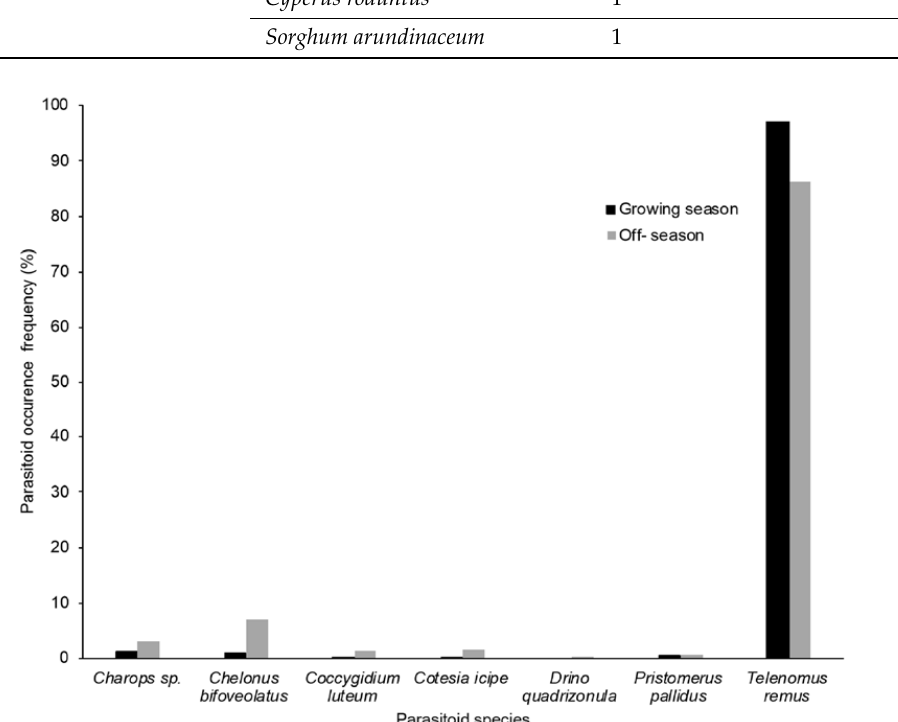
Figure 3. Occurrence of parasitoid species recorded in maize growing and off-seasons in southern and central Benin. The percentage of parasitoid frequency was calculated by dividing the number of the parasitoid species records by the total records of all parasitoid species.